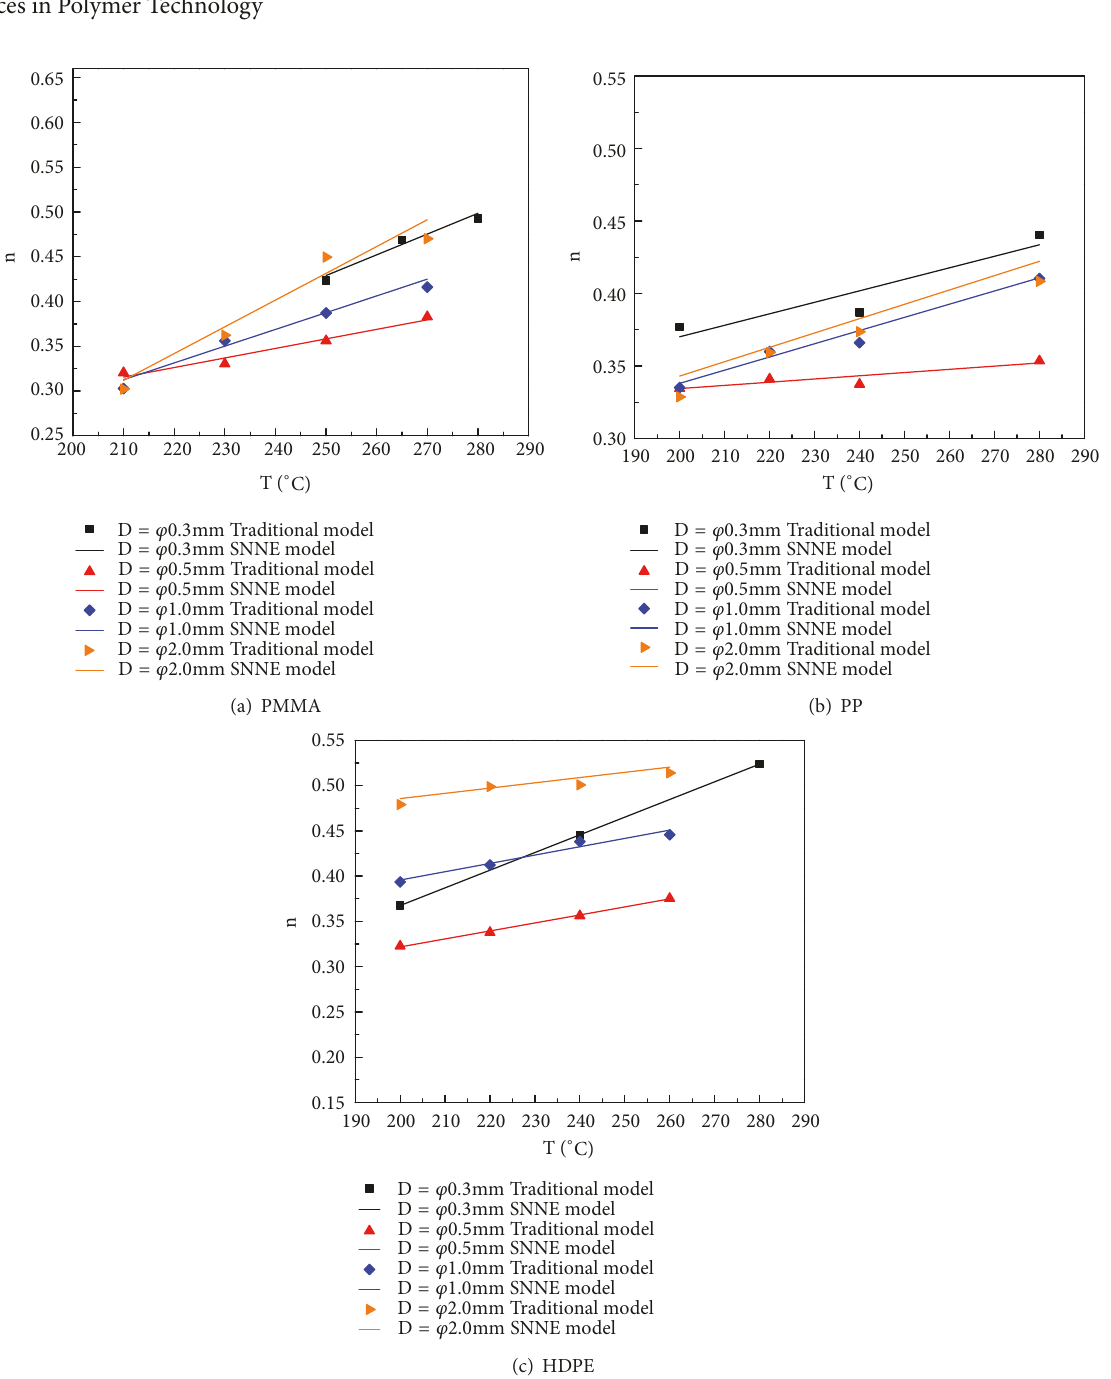
Figure 6: Comparison of the non-Newtonian index values of the traditional power law model and the SNNE model. (a) PMMA; (b) PP; (c)